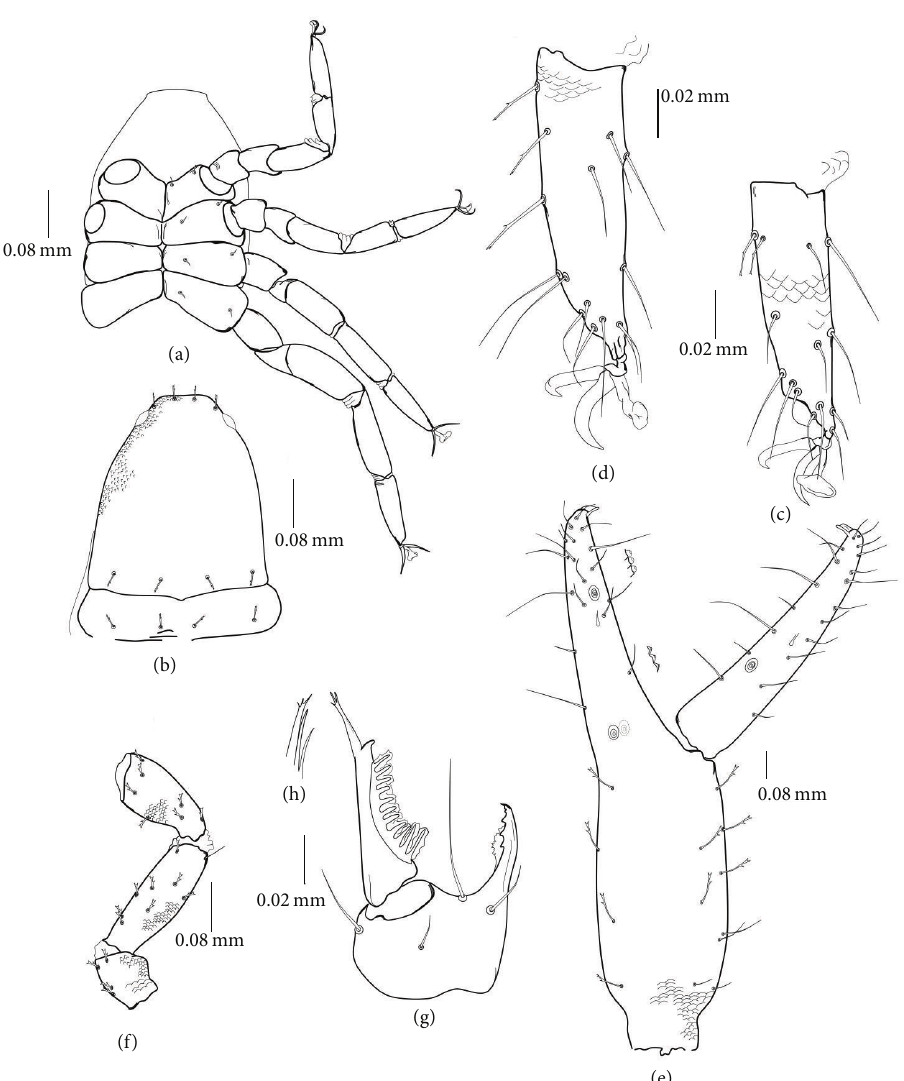
Figure 3: Protonymph: (a) legs and ventral view of carapace, (b) dorsal side of carapace, (c) tarsus of leg I, (d) tarsus of leg IV, (e) right chela, (f) pedipalp, (g) chelicera, and (h)